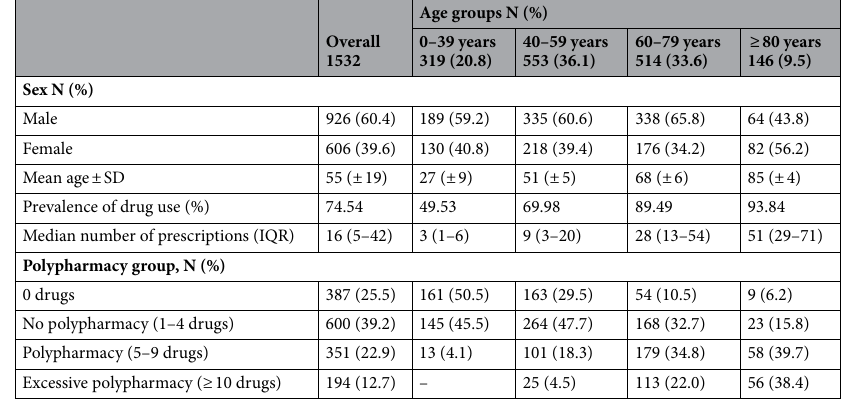
Table 1. Characteristics of the COVID-19